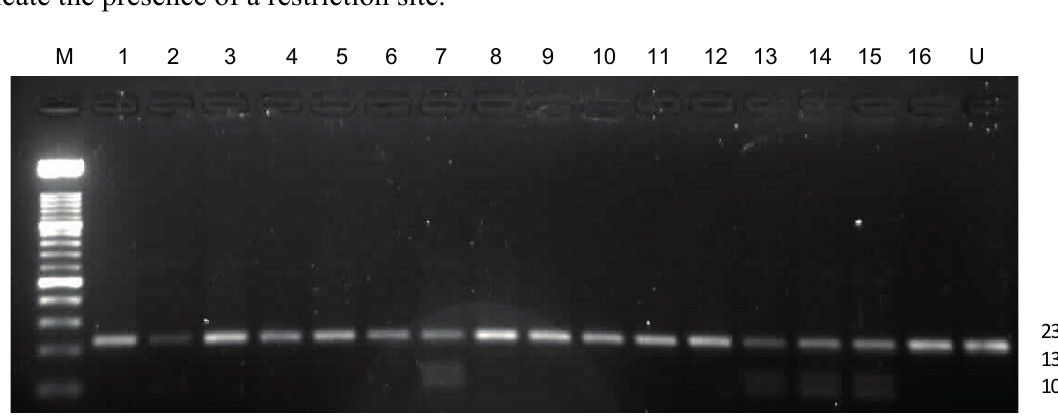
Figure 2. A representative 2% agarose gel of restriction digestion products with FokI for APOC3 − 455 genotyping. Restriction patterns obtained with FokI were as follows: Lane M, 100 bp molecular marker; Lanes: 1–6, 8–12 and 16: CC variant genotype (no restriction site); Lanes 7 and 13–15, wild type TT genotype; and Lane U: undigested sample (no enzyme added). One band indicates the absence of a restriction site; three bands indicate the presence of a restriction